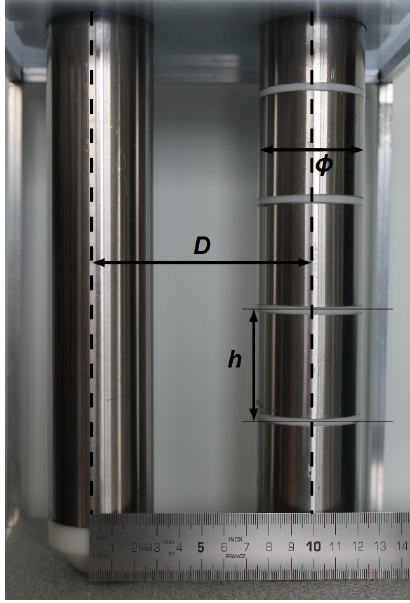
Figure 1. Photograph of sensor electrodes and their five channels. The dimensions for one channel are shown by a ruler: φ is the electrode diameter ( φ = 50 mm), D the distance between their axes ( D = 100 mm) and h their height ( h = 50